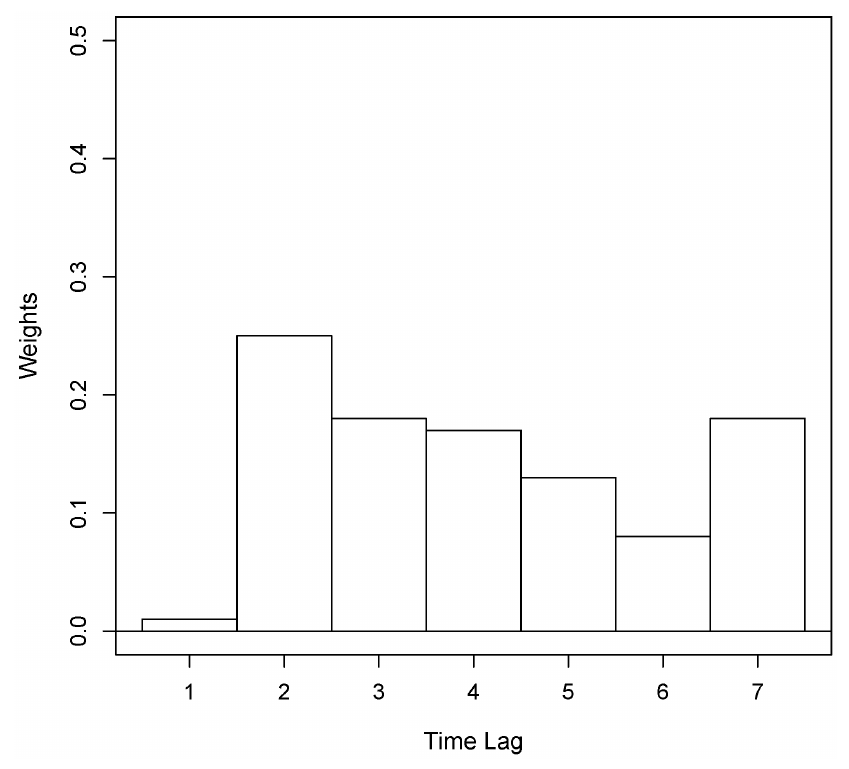
Figure 8. Maximum likelihood estimation on the temperature effect distribution of different time lags.